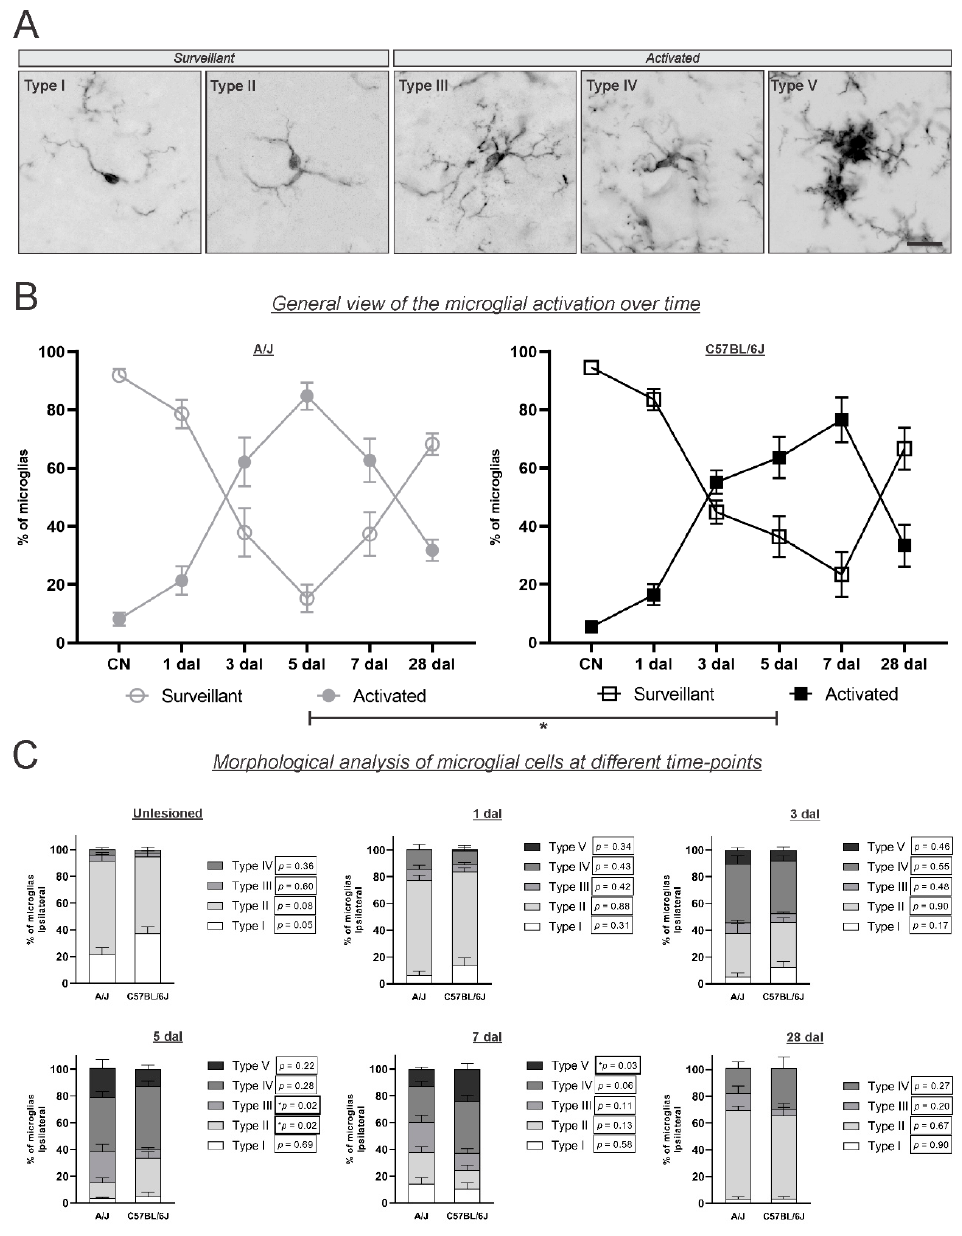
Figure 5. Morphological analysis of microglial activation in the A/J and C57BL/6J strains over time. ( A ) Representative photomicrographs of Iba-1 immunostained microglia classified, according to their morphology, into surveillant (types I and II) and activated microglia (types III, IV, and V). Scale bar: 10 µm. ( B ) Quantification of microglial cells in the surveillant and activated categories in the different experimental groups over time. Note that there was an increase in the activation percentage after the lesion, occurring in a time-dependent manner, which peaked in the A/J strain at 5 dal, earlier than in the C57BL/6J strain (* p = 0.03). ( C ) Detailed morphological typing of microglial cells or each experimental group and time point. Data were analyzed by comparing the two strains with an unpaired t -test at each time point. Note the higher percentage of type III microglia (the less activated morphology) in the A/J strain at 5 dal than in the C57BL/6J strain (* p = 0.02), and the increased level of type V microglia (the most activated morphology) in the C57BL/6J strain at 7 dal compared to the A/J strain (* p = 0.03).